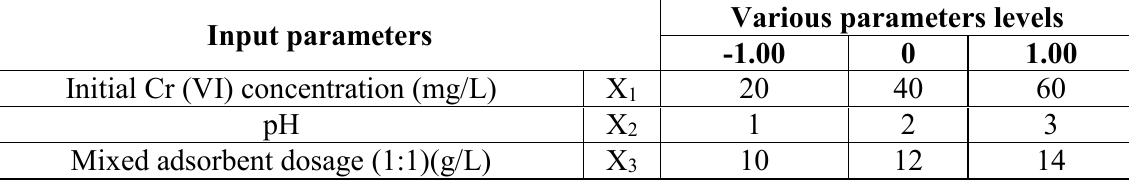
Table 1. The experimental design parameters ranges and its levels.